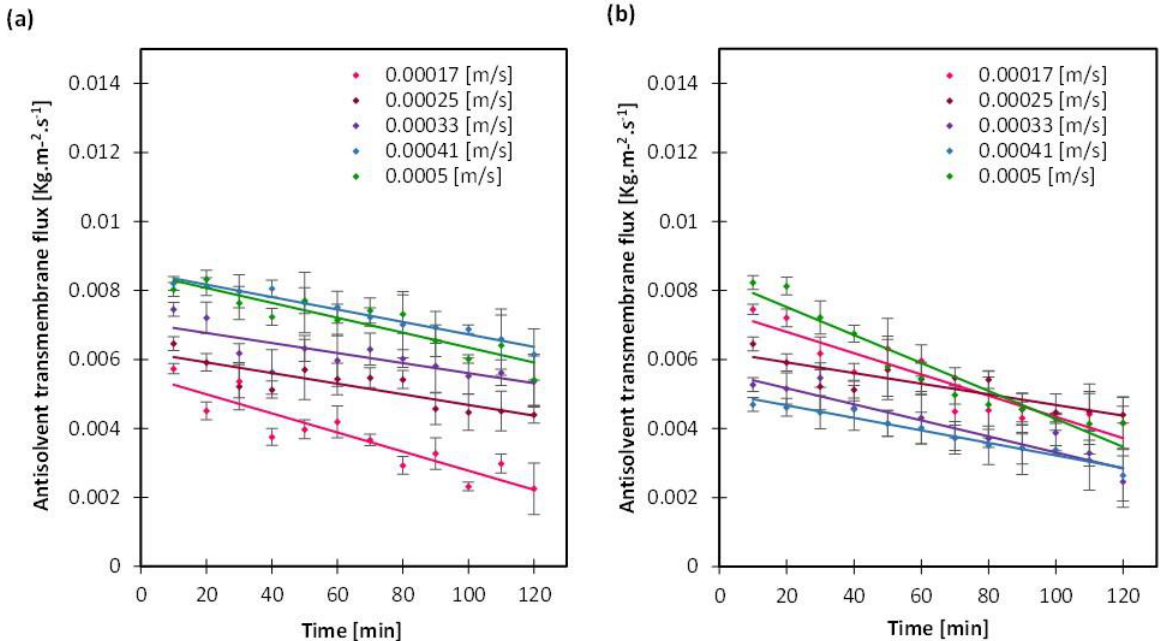
Figure 4. Antisolvent transmembrane flux with variation of ( a ) the crystallizing solution and ( b ) the antisolvent solution from 0.00017 to 0.00025 m/s. Lines are added to guide the eye.